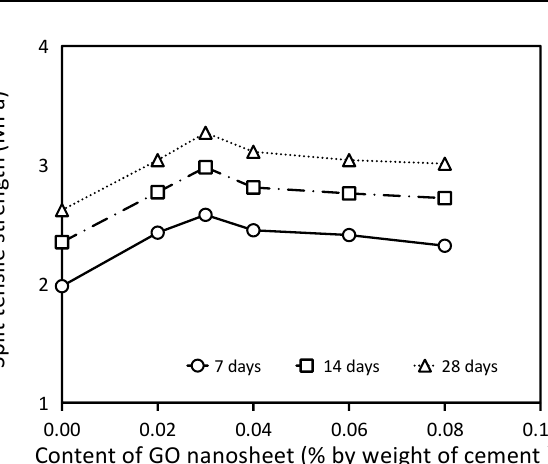
Figure 9. Split tensile strength of concrete at different ages.